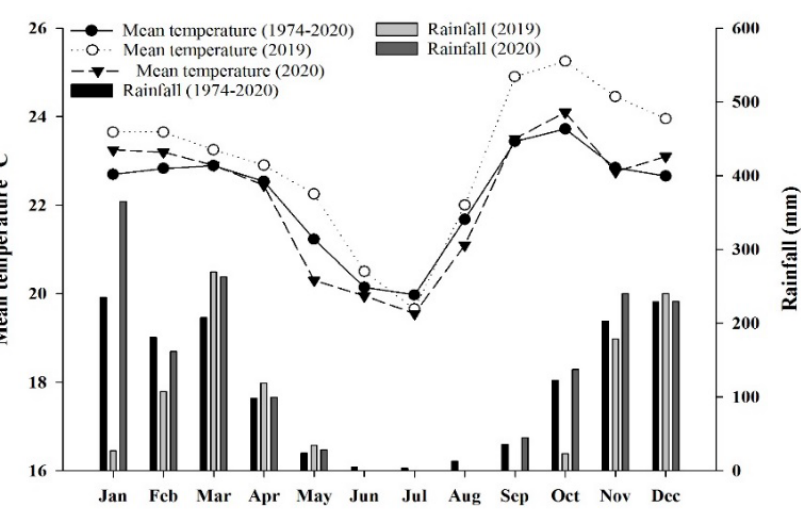
Figure 8. Climatic data of precipitation and mean temperature from 1974 to 2020 in the experimental